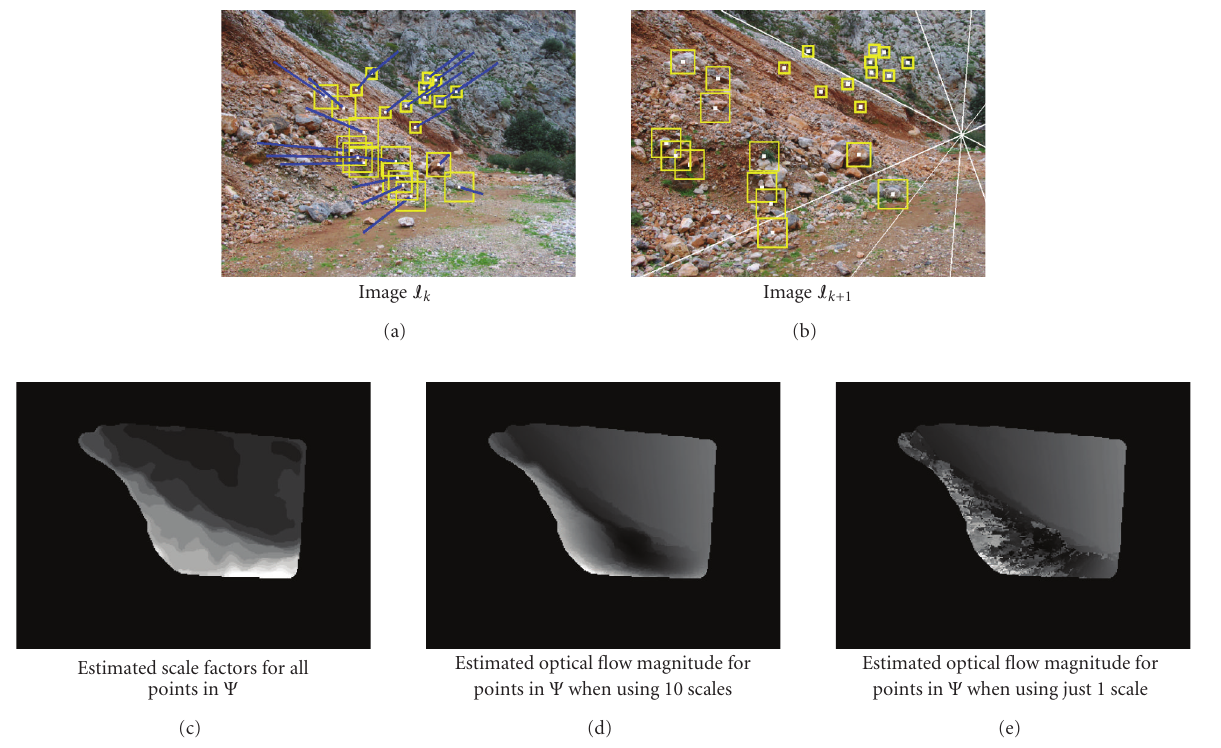
Figure 5: On the top row, we show again the two images I k , I k +1 from Figure 4 along with computed optical flow vectors (blue segments) for a sparse set of points (a few epipolar lines are also shown in I k +1 ). In both of these images, the yellow square around a point is proportional to the point’s estimated scale factor (10 scales S = { 1,0 . 9 − 1 , ... ,0 . 1 − 1 } have been used). On the bottom row, we show the estimated scale factors for all the points in region Ψ , as well as the corresponding optical flow magnitudes at these points. Regarding optical flow, two results are shown: when using 10 possible scales S = { 1,0 . 9 − 1 , ... ,0 . 1 − 1 } , as well as when using just one scale S = { 1 } . As expected, in the latter case, the estimated flow is quite noisy, since the algorithm fails to produce exact optical flow for points that actually undergo a large change of scale. We note that darker pixels (in a grayscale image) correspond to smaller